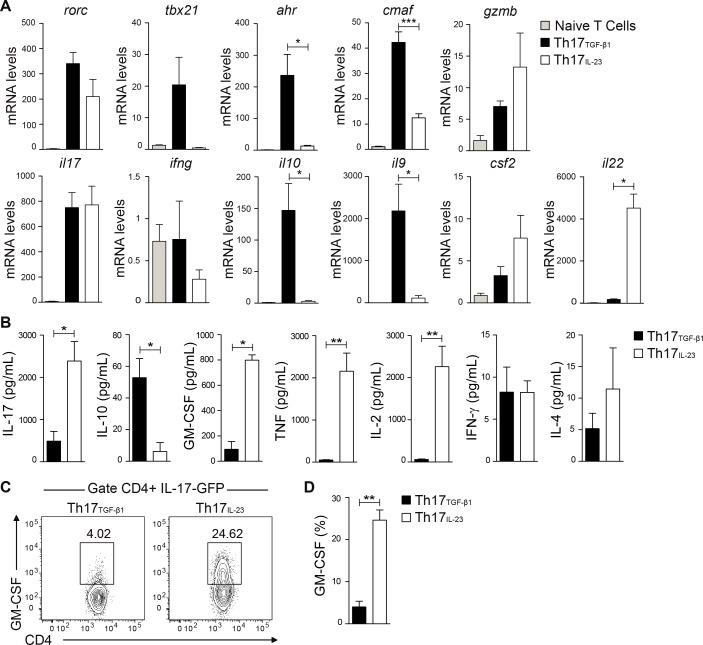
Th17TGF-β1 cells present a regulatory phenotype.(A) IL-17-GFP+ Th17TGF-β1 and Th17IL-23 cells were sorted and then analyzed by real-time PCR for mRNA expression of several transcription factors and cytokines (n = 3). (B) IL-17-GFP+ Th17TGF-β1 and Th17IL-23 cells were sorted and then reactivated for 4 hrs with PMA plus ionomycin to assess cytokine production by CBA or (C) in the presence of PMA, ionomycin and brefeldin A to analyze GM-CSF production by FACS (n = 5). (D) Percentage of GM-CSF+ cells within IL-17-GFP+ Th17TGF-β1 and Th17IL-23 cells (n = 5). Data are presented as mean ± S.E.M. *p<0.05, **p<0.01 and ***p<0.001 determined by t-test (A) or Mann-Whitney test (B and D).